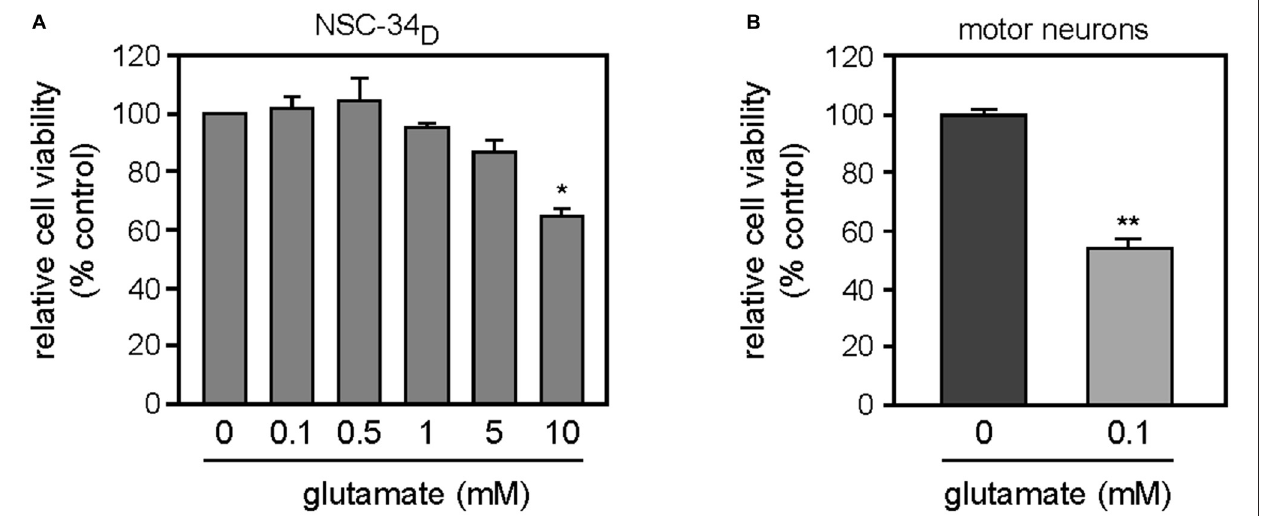
FIGURE 3 | (A) Effects of glutamate on NSC-34 D cell cultured in DMEM/Ham’s F12 without RA. Cells were exposed to increasing concentrations of glutamate (ranging from 0.1 to 10 mM) for 48 h before counting. (B) Effects of glutamate on survival of primary MN, cells were exposed at 8 DIV to 0.1 mM glutamate for 48 h before counting. Data were analyzed by Mann-Whitney test or Kruskal-Wallis (multiple comparisons) to detect statistical significance. Statistically significant difference from untreated cells ∗ p < 0.05, ∗∗ p < 0.01. Data are mean ± SEM ( n =